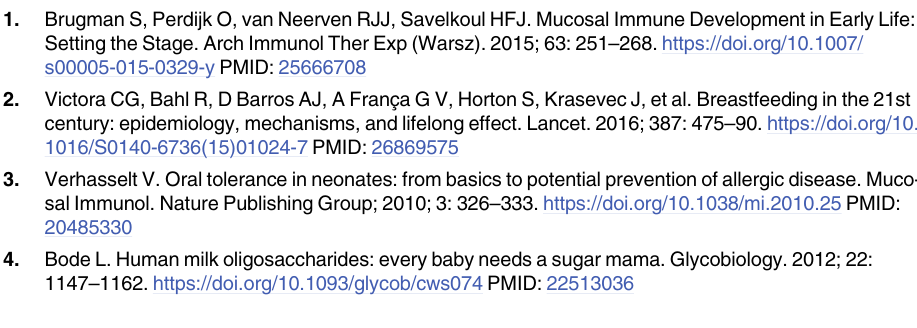
S1 Table. Conjugated antibodies used for flow cytometry.